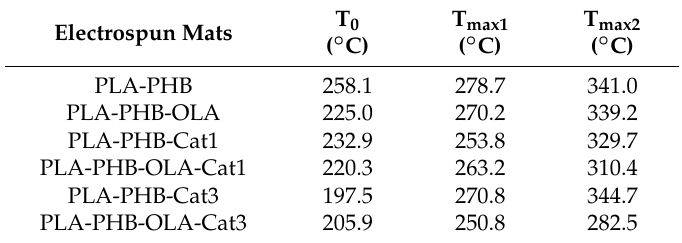
Table 2. TGA and DTG results of the electrospun fiber mats.